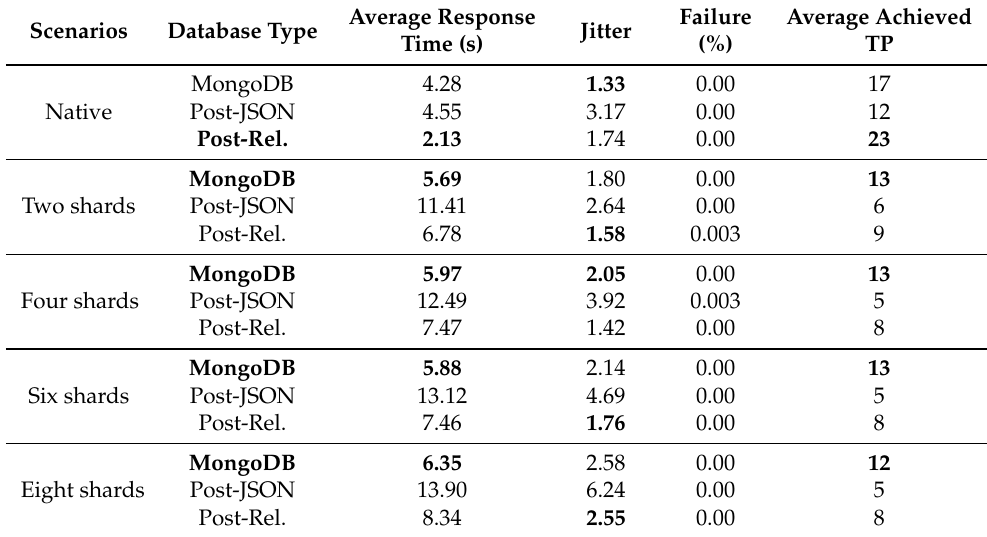
Table 2. Average of response time and throughput, jitter and failure in MongoDB, Postgres JSON and Relational PostgreSQL for the representative case of 10 K client throughput in the select (Q2) case.